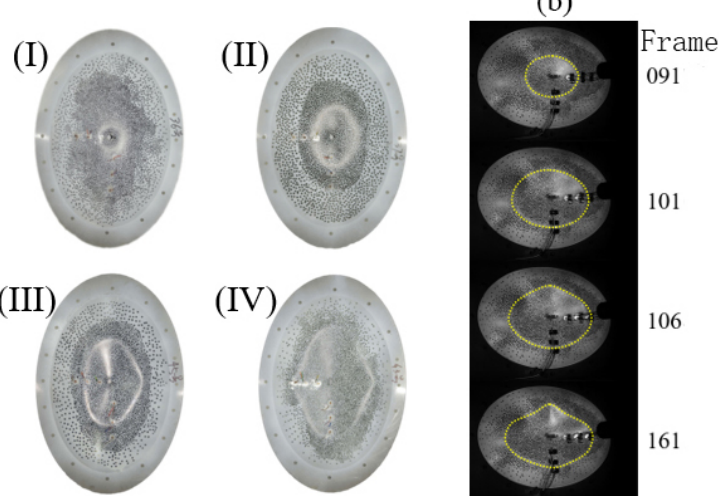
Figure 4. Deformation mode and evolution of impacted ellipsoidal shell. ( I ) for mode I, ( II ) for mode II, ( III ) for mode III and ( IV ) for mode IV. ( b ) indicates the evolution of the deformation mode